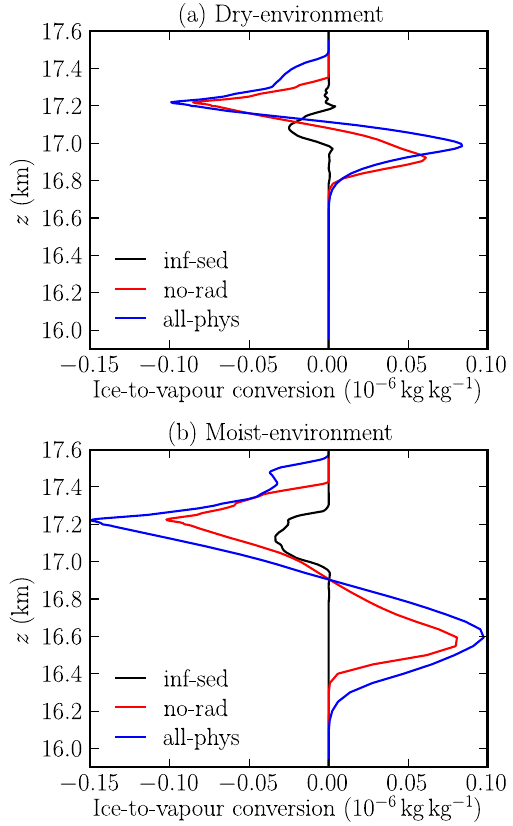
Figure 5. The profiles of accumulative mass exchange from ice to vapour over the model integration in (a) the dry scenario and (b) the moist scenario.